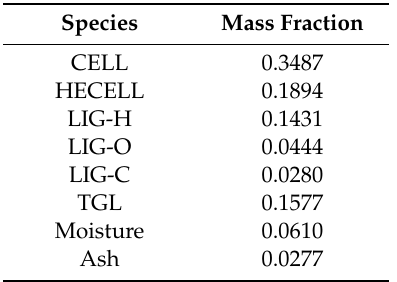
Table 3. Characterization of co ff ee